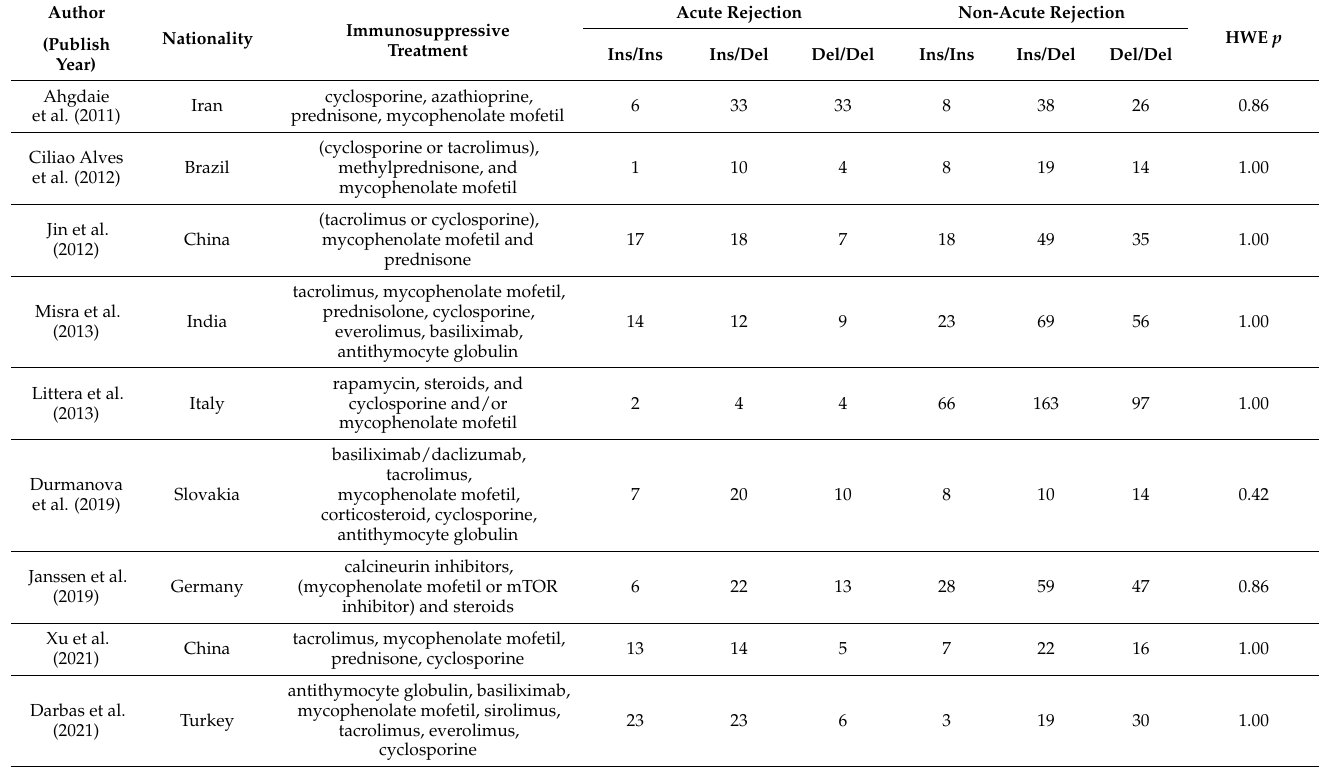
Table 1. Characteristics of eligible studies included in the